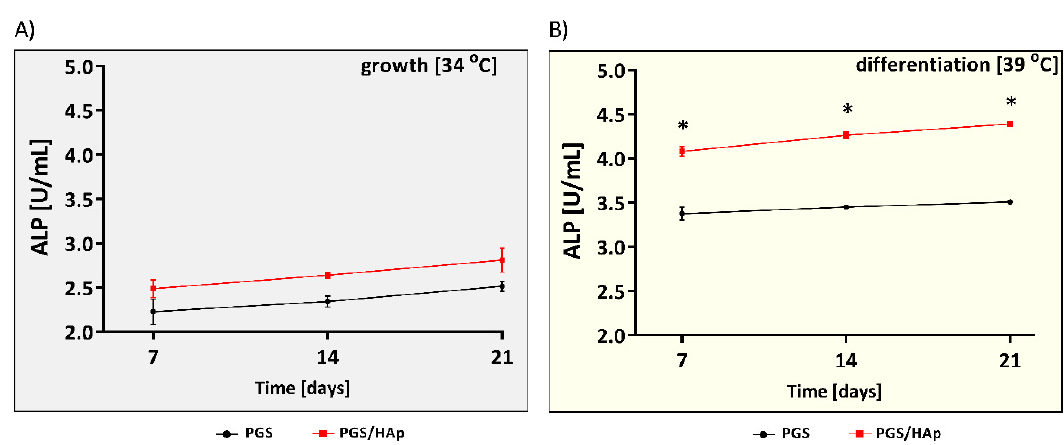
Figure 11. Alkaline phosphatase (ALP) activity in cell lysates obtained from hFOB1.19 cells cultured at 34 °C ( A ) or in the osteoinductive environment at 39 °C ( B ). The results represent the mean ALP activity ± SD. * p < 0.05 between the PGS and PGS/HAp composites, based on the results of the Mann–Whitney U test .